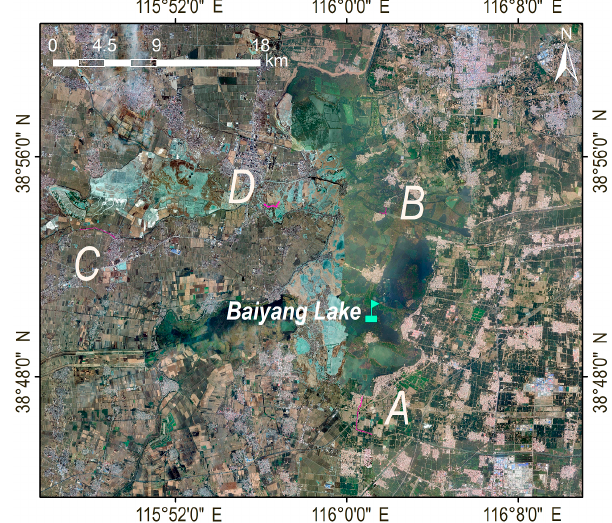
Figure 2. Four channel segments, A, B, C, and D, were selected for data acquisition and analysis.